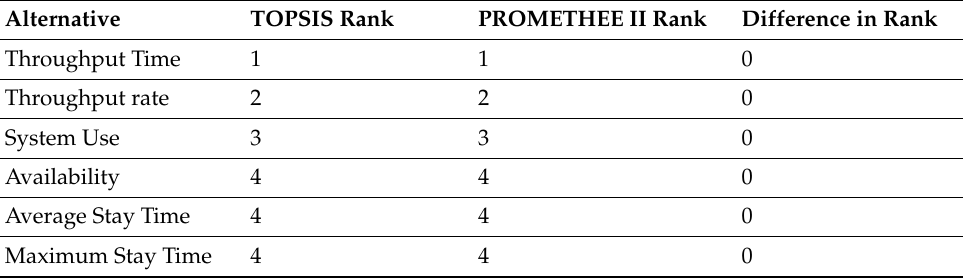
Table 17. Comparison between TOPSIS and PROMETHEE II outputs without breakdown. Alternative TOPSIS Rank Throughput